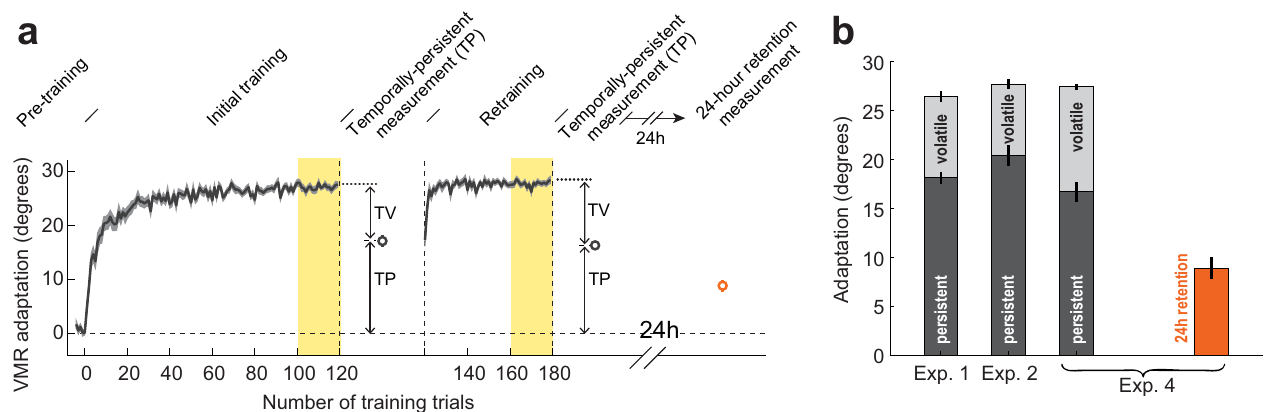
Fig 5. Measuring temporally-volatile and temporally-persistent components of adaptation and subsequent long-term retention. (a) Experiment schedule and raw data for Experiment 4. After a baseline period, subjects were trained with a 30˚ VMR for 120 trials, and were then tested, after a break, for temporally-persistent adaptation, retrained for 60 trials, and then retested after another break. Subjects returned the following day when they were tested for 24-h retention (orange circle). Note that 24-h retention is lower than overall or temporally-persistent adaptation but higher than zero. TP: temporally-persistent; TV: temporally-volatile. Yellow background indicates trials used to measure overall adaptation. Error bars and shading indicate SEM. (b) Comparison of overall, temporally-persistent, and temporally-volatile adaptation from Experiments 1, 2, and 4 with the 24-h retention from Experiment 4. Experiments 1, 2, and 4 display similar levels of persistent and volatile adaptation. Underlying data supporting this figure can be found in file